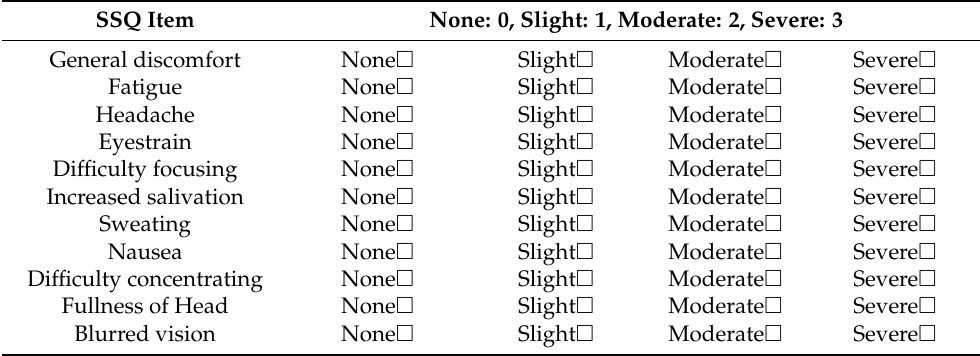
Table A1. Simulator sickness questionnaire [45]. Instruction: Circle how much each symptom below is affecting you right